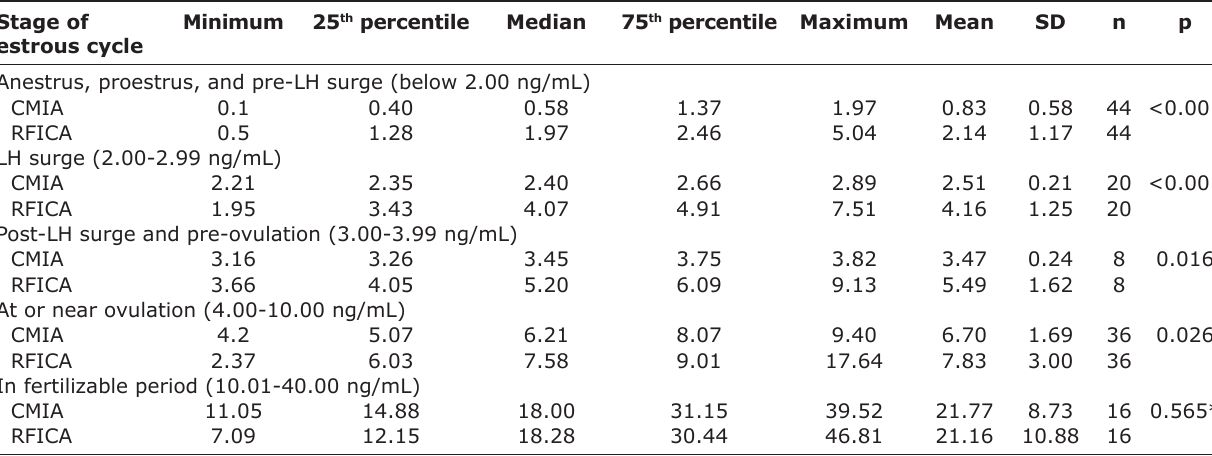
In fertilizable period (10.01-40.00 ng/mL) CMIA